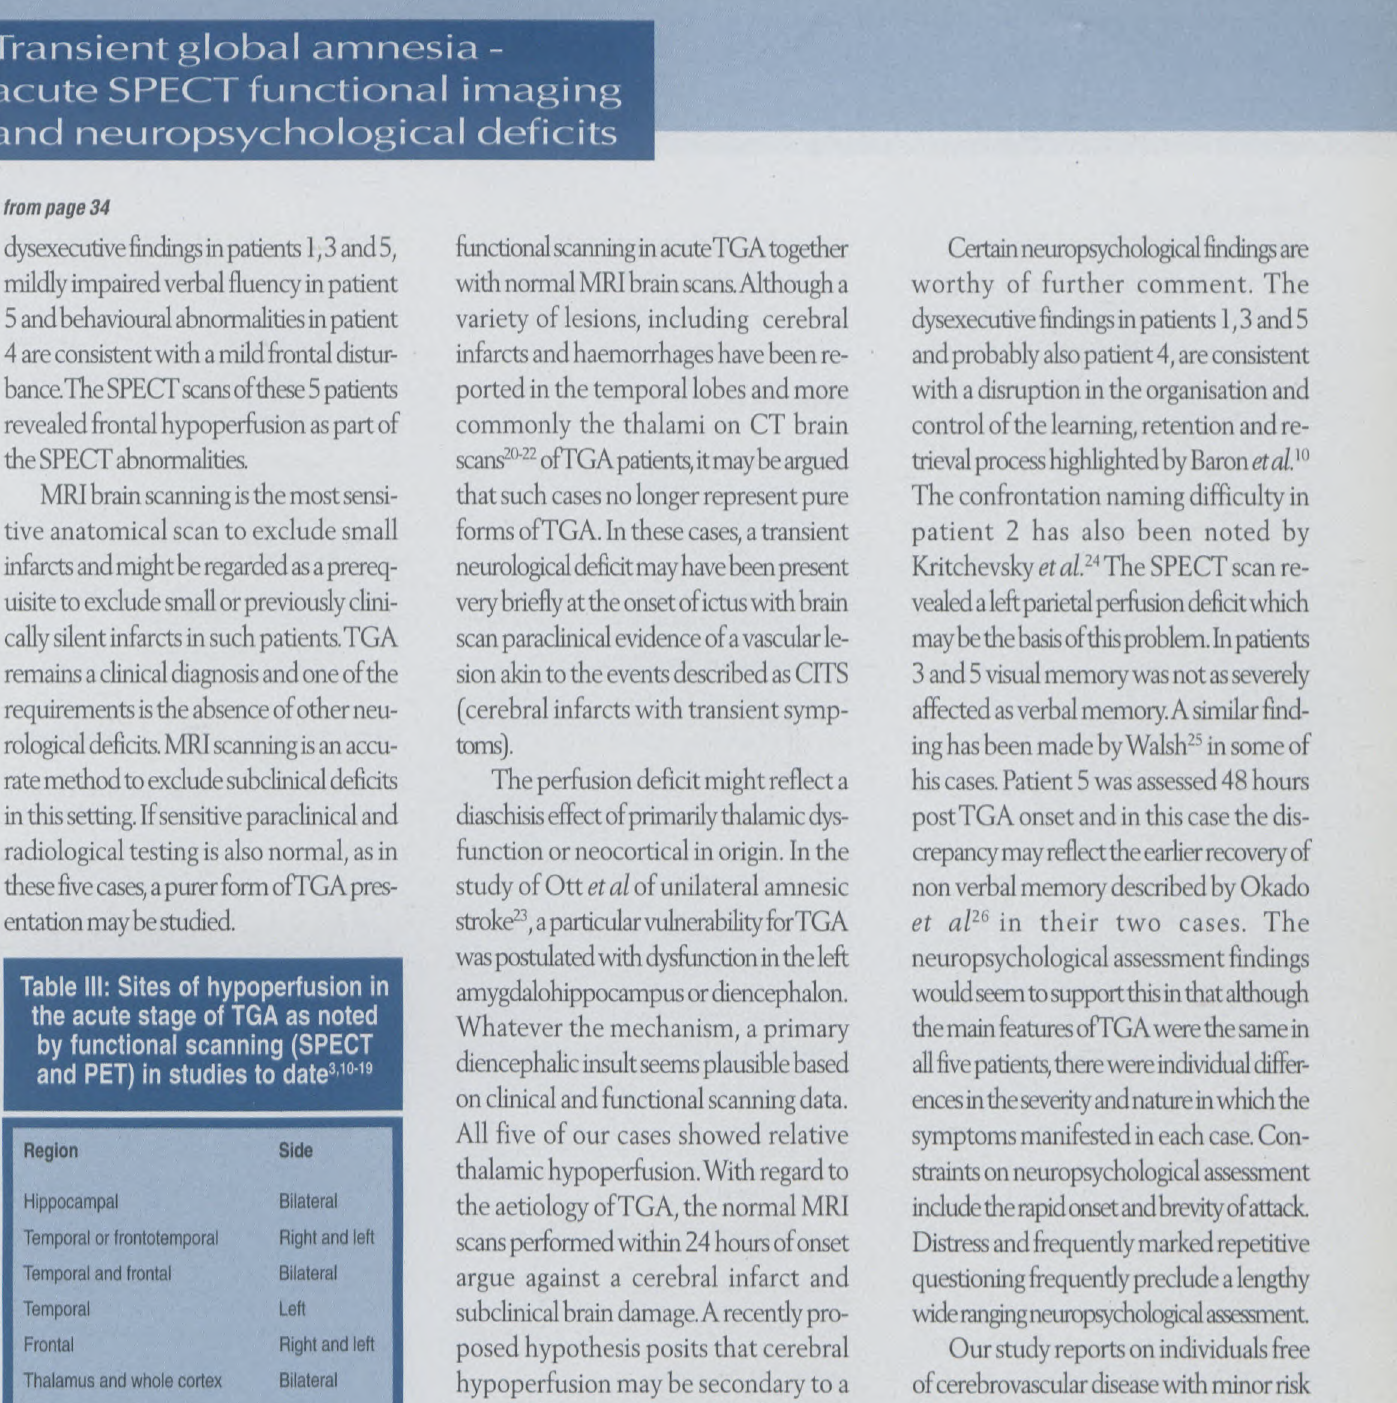
Table III: Sites of hypoperfusion in the acute stage of TGA as noted by functional scanning (SPEeT and PET) in studies to date